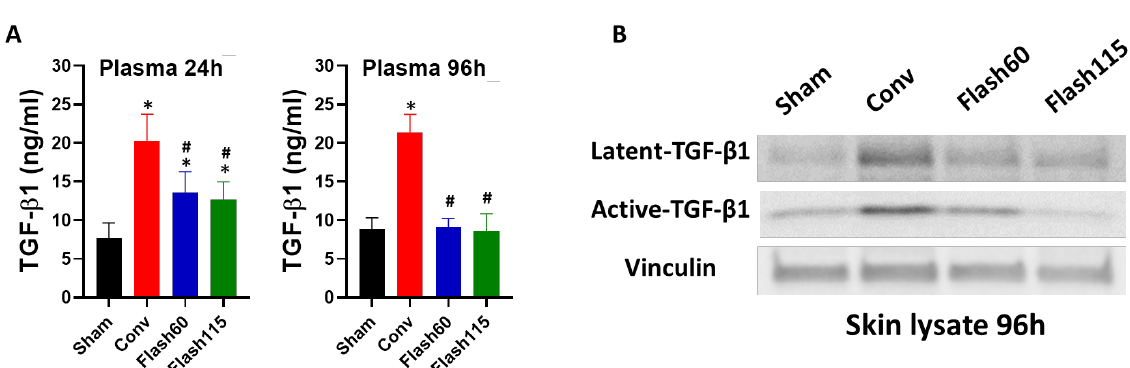
Figure 2. Decreased early TGF-B1 production following FLASH PBS versus Conv irradiation. Right hind legs of the mice were PBS-irradiated with 35 Gy or left untreated (Sham) with dose rates of 1 Gy/s (Conv), 57 Gy/s (Flash60) and 115 Gy/s (Flash115). ( A ) Plasma measurement of total TGF-B1 by ELISA at 24 and 96 h post irradiation of the mice at the different indicated dose rates ( n = 8/group). ( B ) Detection of latent (45 kD) and activated (12 kD) TGF- β 1 by Western blot analysis in individual sham or irradiated mouse leg skin at 96 h post treatment is shown. Vinculin was used as a loading control. Differences between conditions were determined by a one-way ANOVA test with a multiple-comparison Tukey correction. * p ≤ 0.05 vs. Sham and # p ≤ 0.05 vs. Conv. Bars represent the mean +/ − SD. The whole western blot figures can been see in the Supplementary Materials.